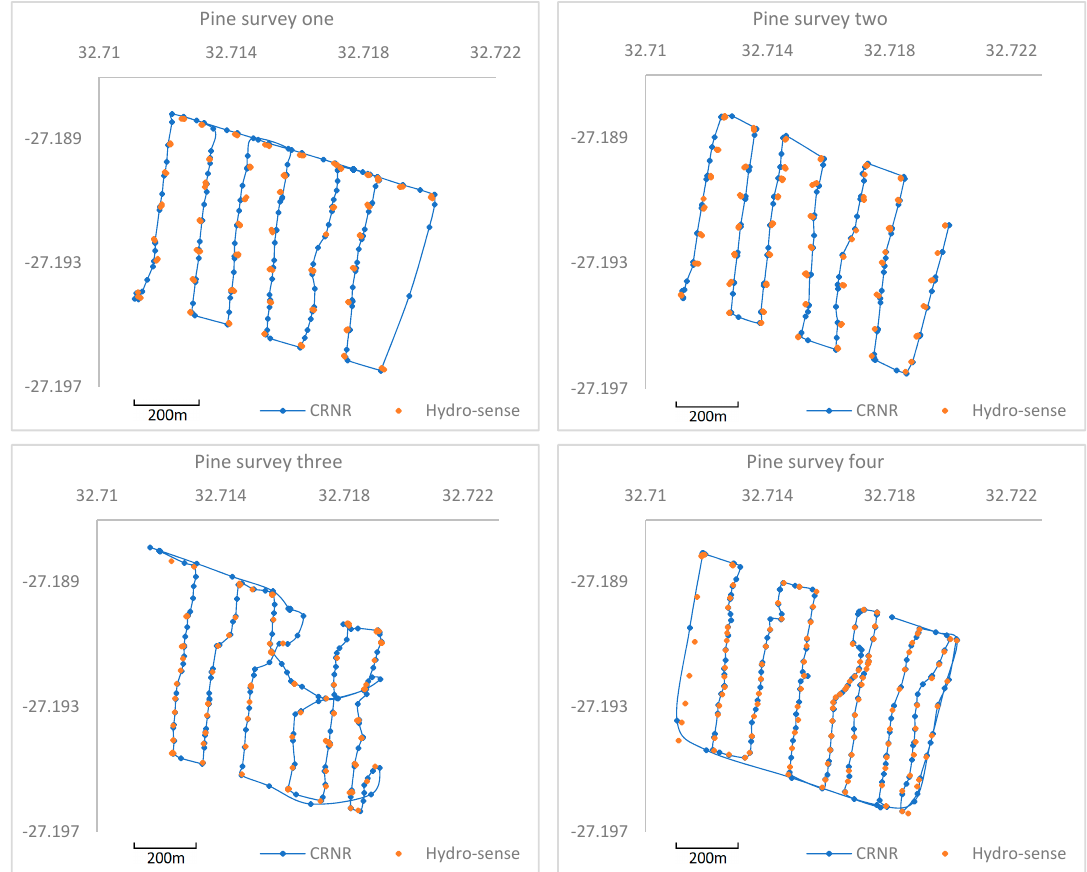
Figure 4. CRNR paths and hydro-sense points of pine stand surveys.